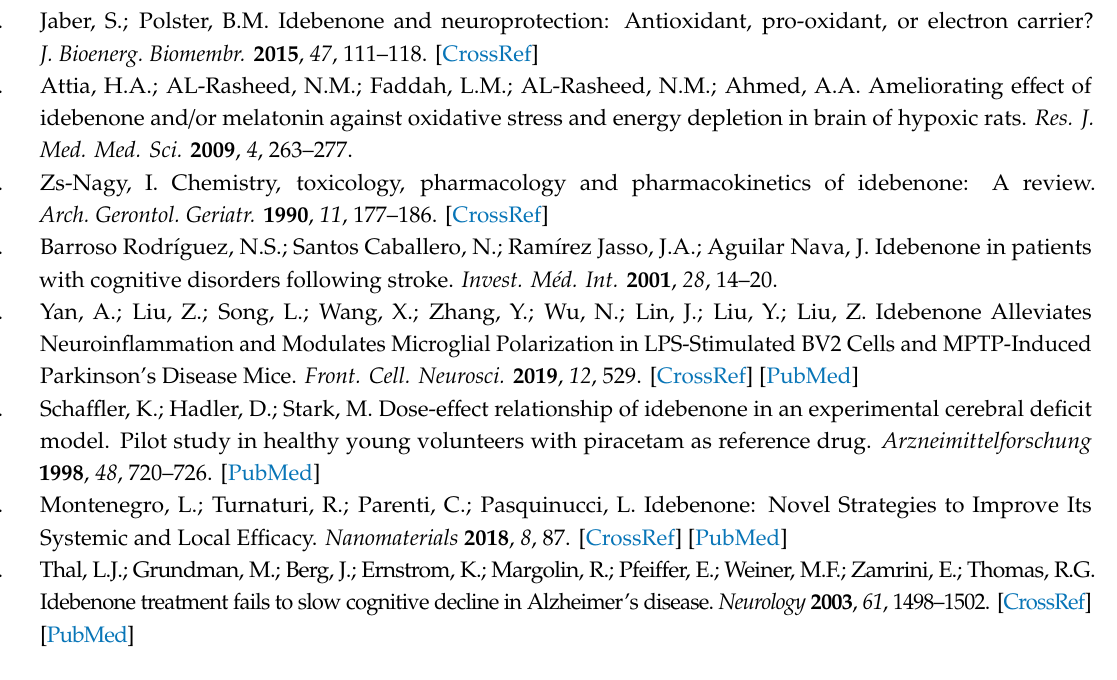
Figure S1: Plot of peak area versus di ff erent IDE concentrations; Figure S2: 1 H NMR spectrum of HP- β -CD; Figure S3: 1 H NMR spectrum of IDE; Figure S4: 1 H NMR spectrum of IDE / HP- β -CD inclusion complex; Figure S5: 2D ROESY plot of IDE / HP- β -CD complex in D 2 O /